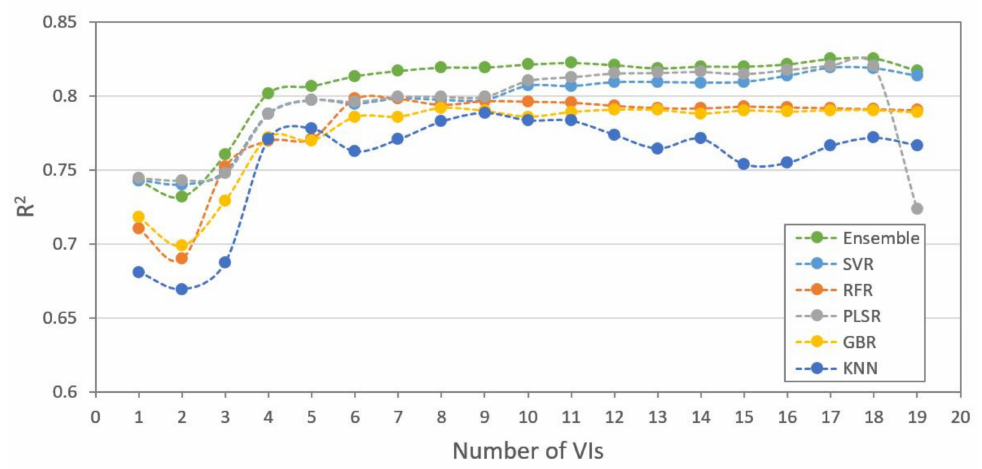
Figure A1. Model training accuracies as a function of the number of VIs derived from 0.007 m GSD RGB data.